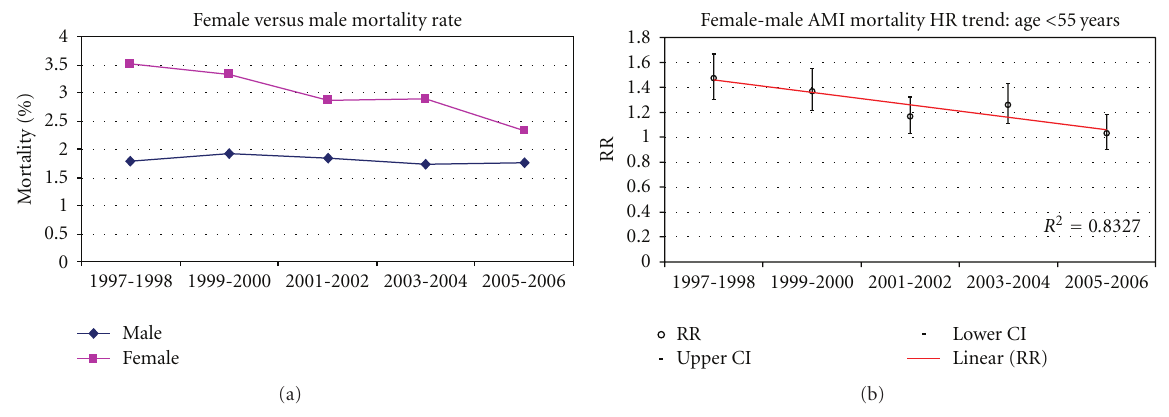
Figure 1: In-hospital AMI mortality rate and relative mortality trend (female versus male) by NIS year for age < 55